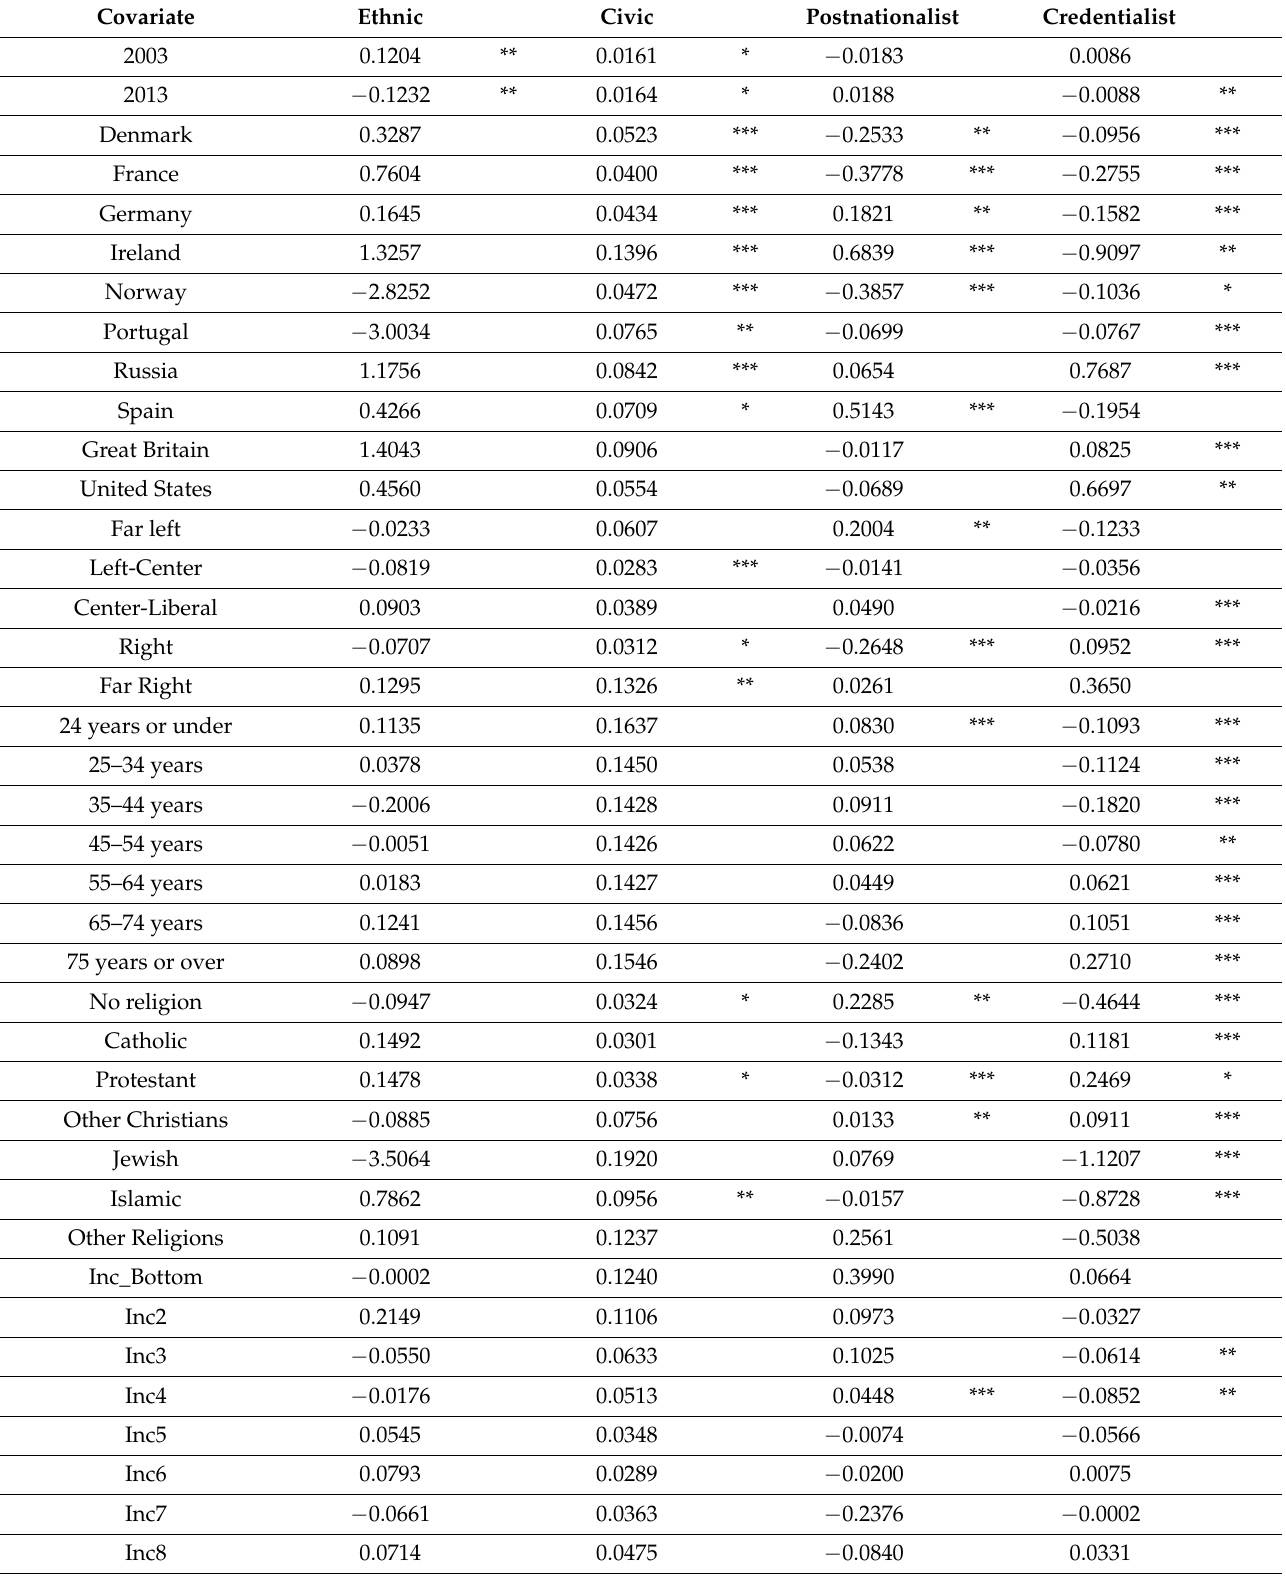
Table A1. Probit model. Coefficients for ethnic, civic, postnationalist, and